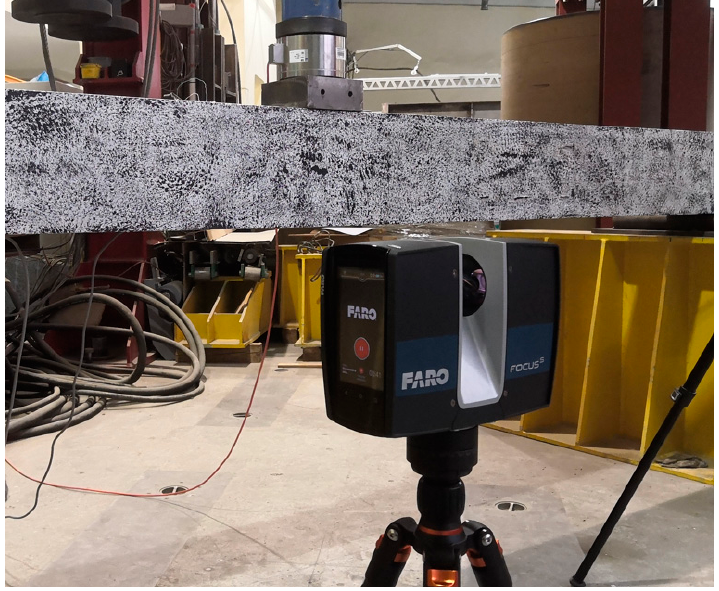
Figure 4. View of the FARO Focus S70 scanner.